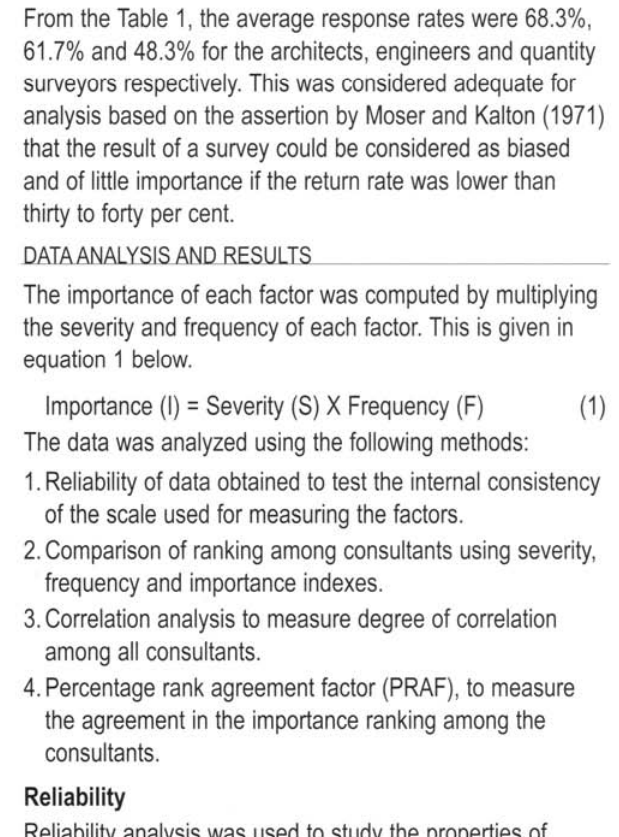
Table 1: Sample Response of Questionnaire Survey \